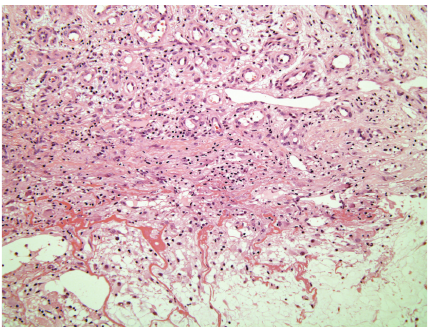
Figure 3: The 1st biopsied abnormal tissue shows inflammatory and edematous thickened tendon sheath with many inflammatory cells. Pathological report was “tenosynovitis.” H&E stain, ×